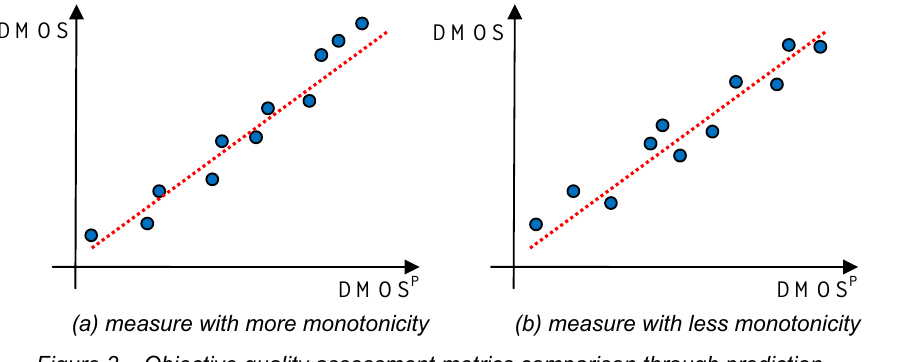
Figure 3 – Objective quality assessment metrics comparison through prediction